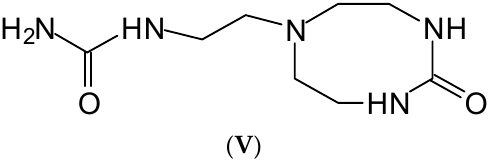
Figure 6. Chemical species ( I – IV ) are formed by the reaction of flavonoid units with the free triamine noy yet involved in the hyperbranched network.